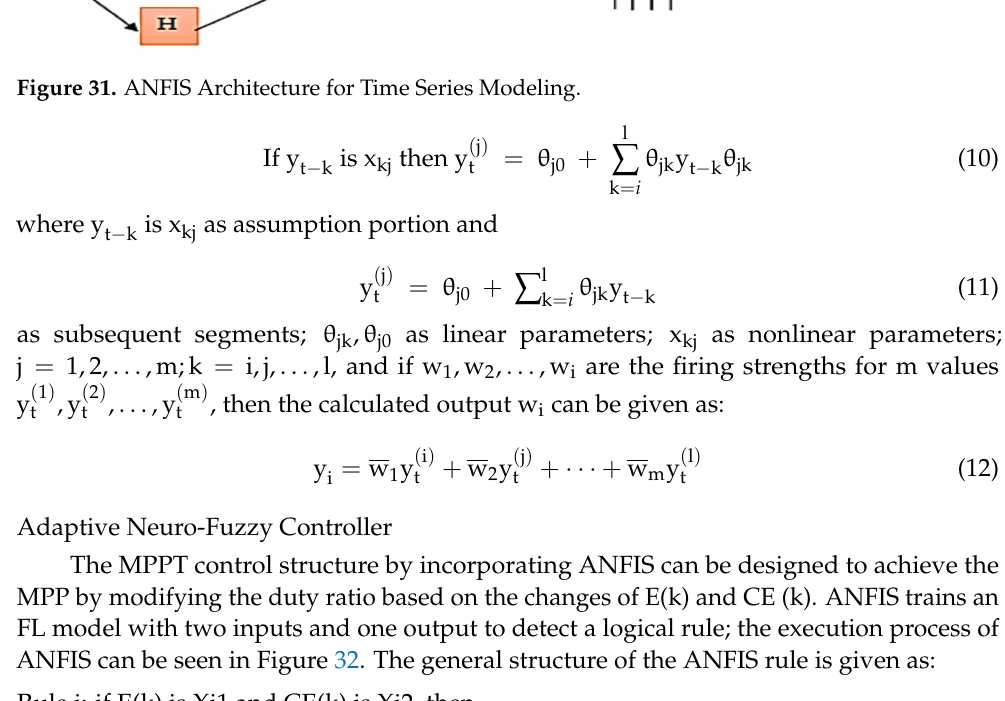
Figure 31. ANFIS Architecture for Time Series